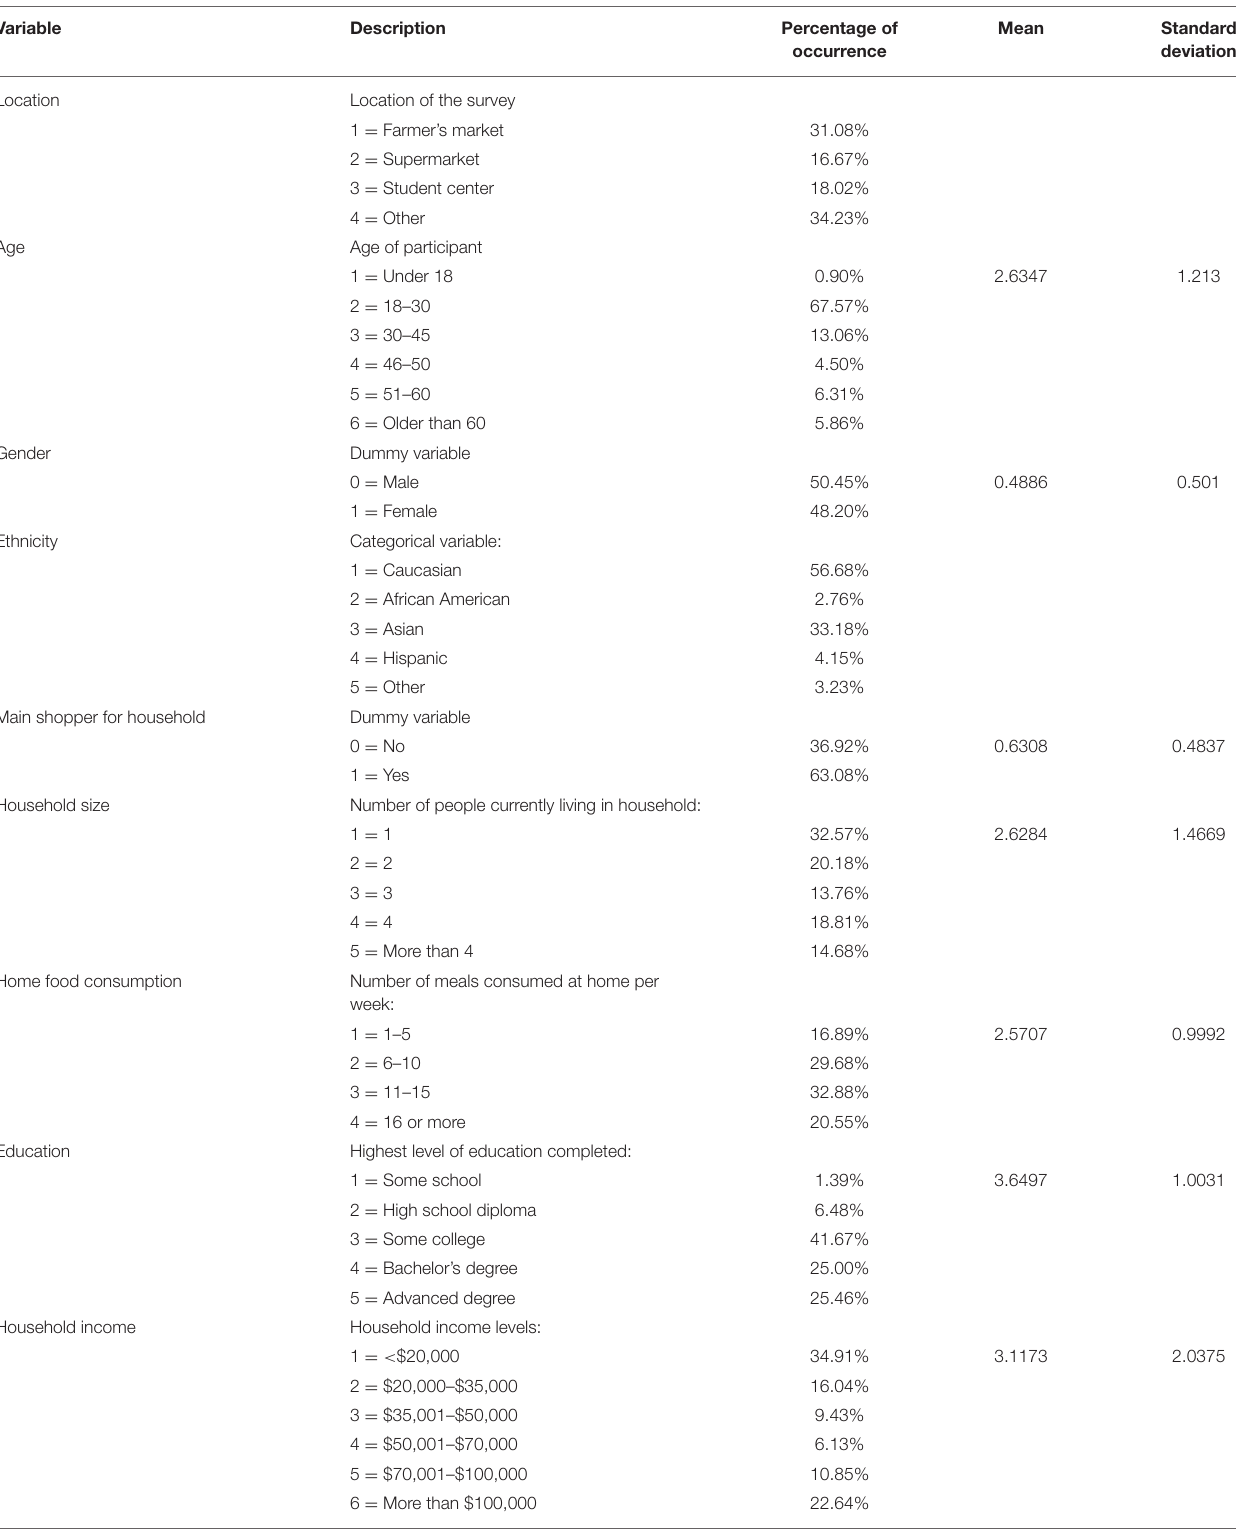
TABLE 2 | Summary statistics for survey